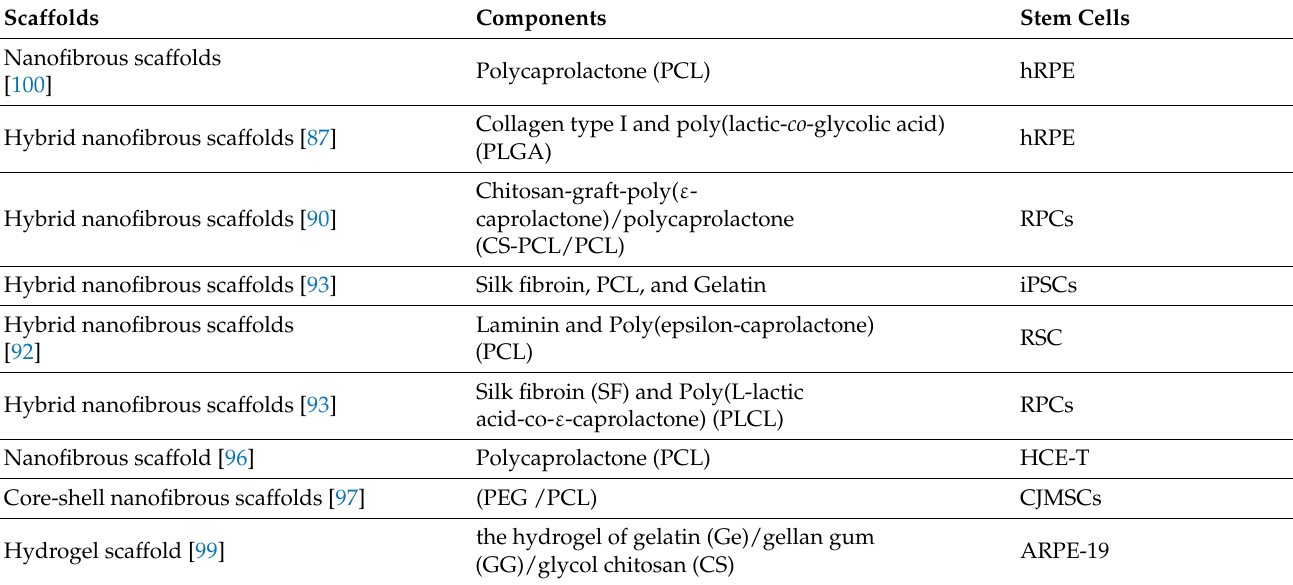
Table 1. Nanomaterial scaffolds applied for ocular tissue